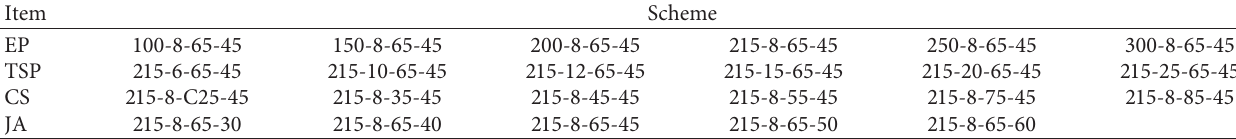
Table 4: Numerical simulation schemes.